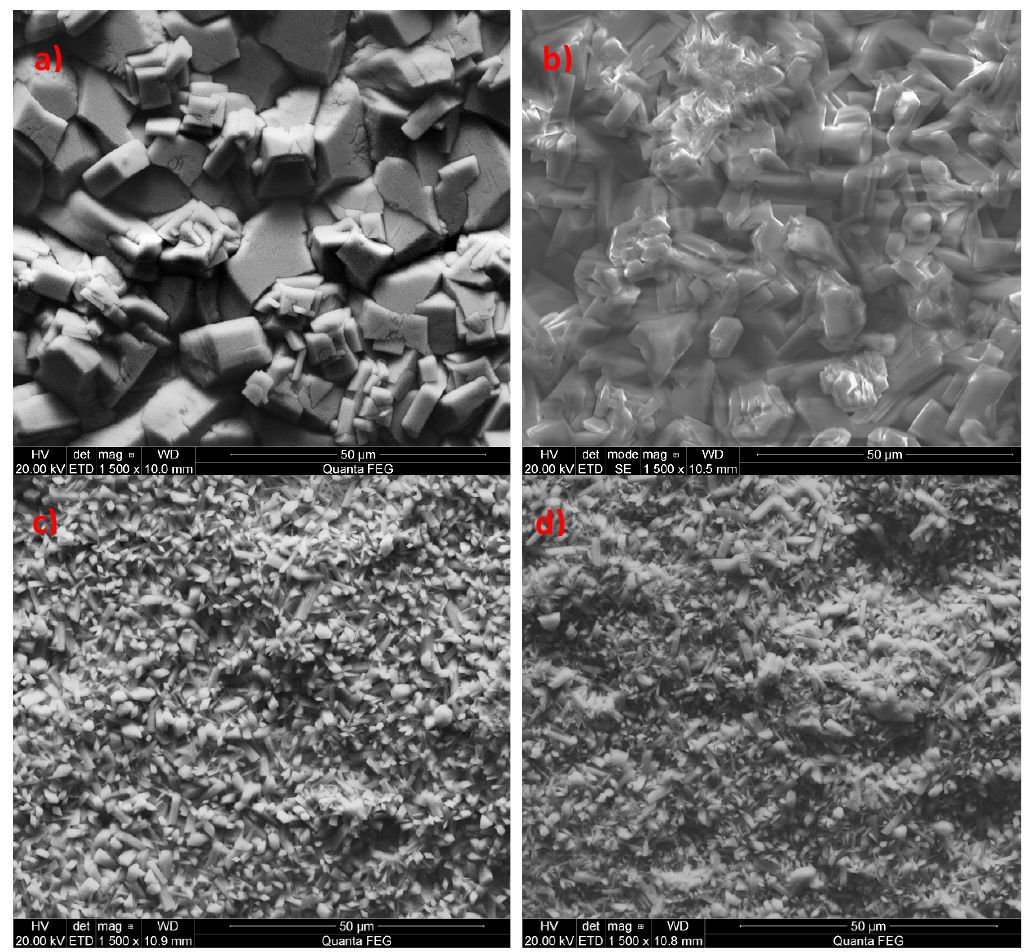
Figure 11. SEM image of phosphate coatings: ( a ) zinc phosphate coating, ( b ) manganese phosphatecoating modified with zinc, ( c ) manganese phosphate coating created under industrial conditions and passivated with hexafluorozirconic acid, ( d ) manganese phosphate coating produced under laboratory conditions and passivated with zirconyl oxychloride.